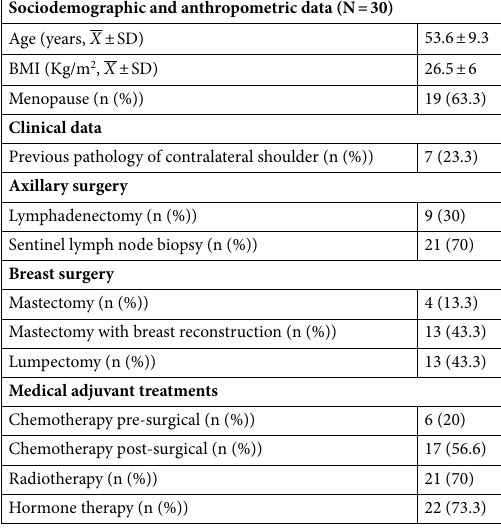
Table 1. Participant characteristics. N Sample size, X mean, SD standard deviation, BMI body mass index, Kg kilograms, n number of